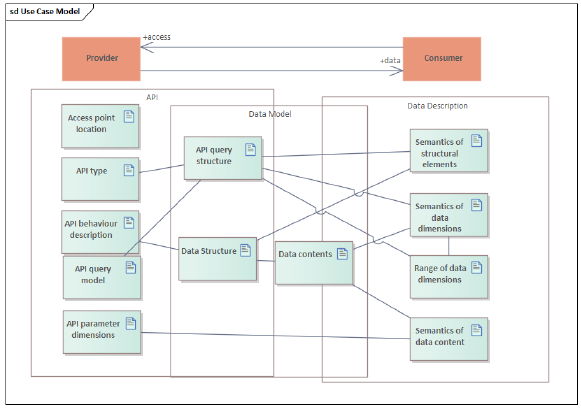
Figure 7. Aspects of Provider-to-Consumer interactions